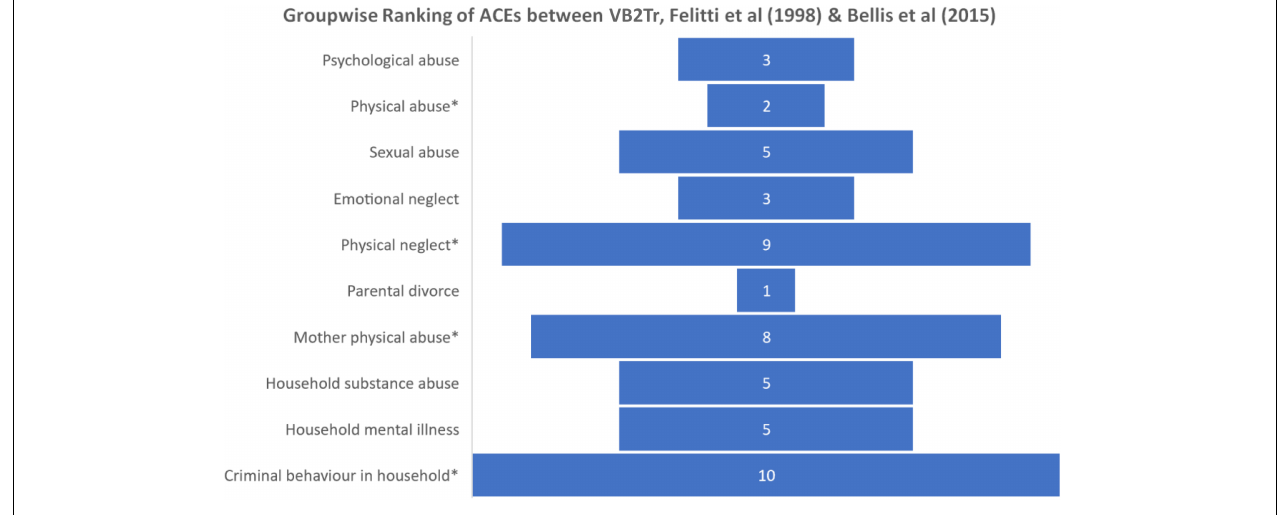
FIGURE 5 | Groupwise ranking of ACEs between groups, * p < 0.001.